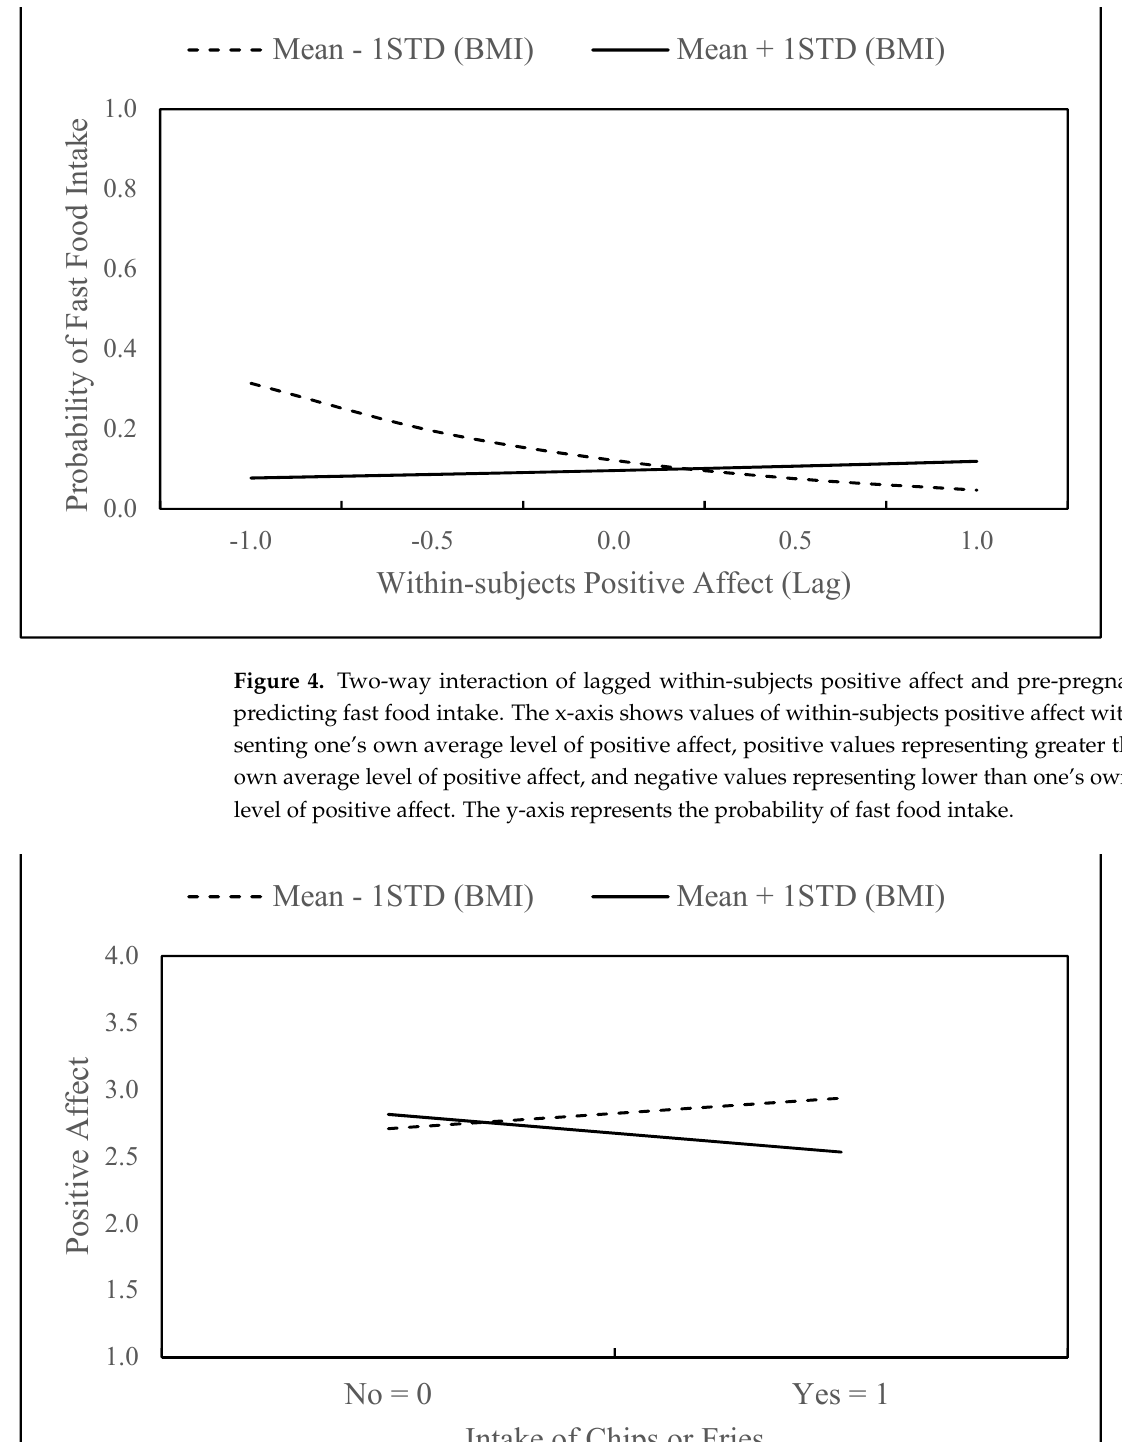
Table 3. Results of Multilevel Models of Food Intake Predicting Affect.